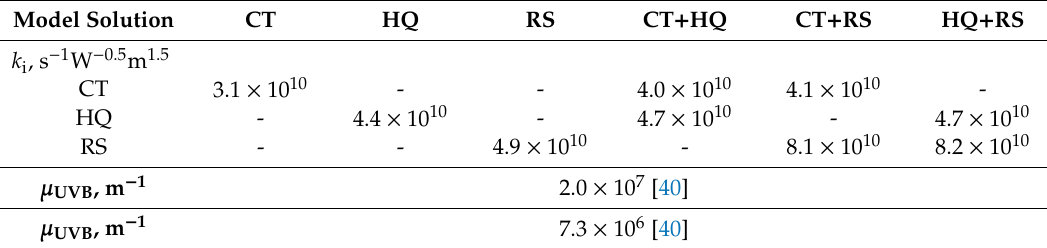
Figure 7. Comparison of experimental data and model values for degradation kinetics CT, HQ and RS in single pollutant model solutions ( a – c ) and binary mixtures ( d – f ) in FPCR and CPC using TiO 2 -GF and TiO 2 / CNT-GF (marked in legend). Models FPCR, FPCR + Y cat and CPC relate to Equations (2)–(4), respectively. Table 1. Kinetic model